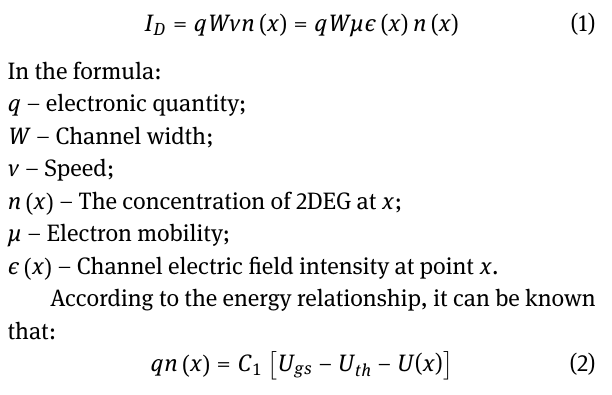
When source-drain voltage is added to the device, source-drain current I can be expressed as, according to D the current density